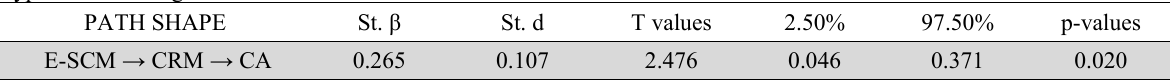
Hypotheses Testing Results for Mediation PATH SHAPE St.